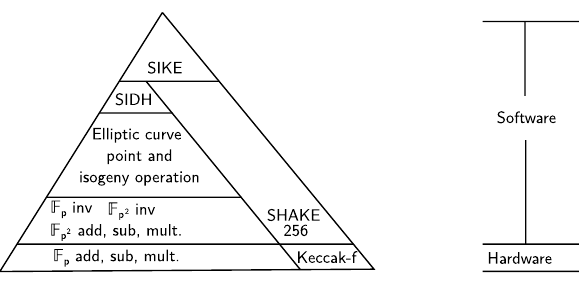
Figure 2: The high-level procedural hierarchy of the SIKE